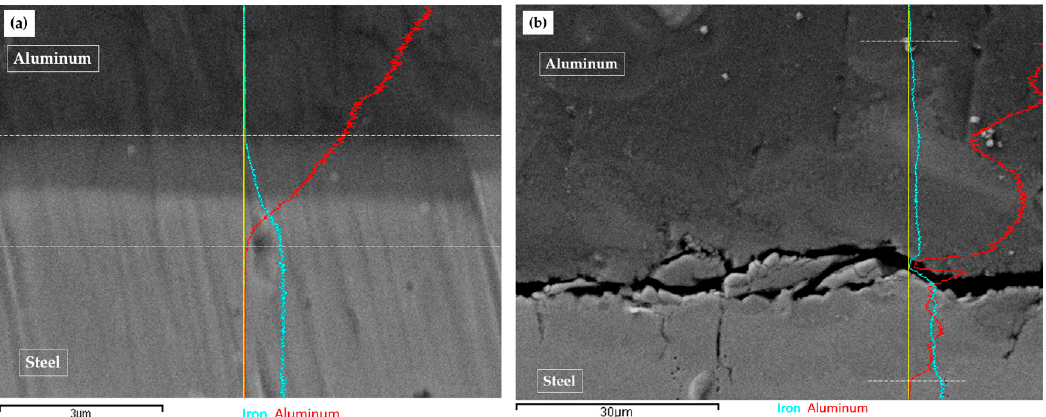
Figure 8. Intermetallic layer thickness determined by EDS line mapping analysis: ( a ) a thin intermetallic layer [11] and ( b ) a thick reaction layer that creates a flake.